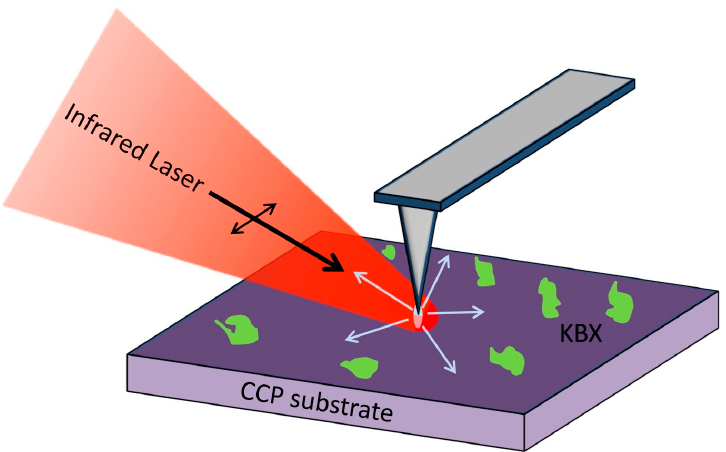
Figure 2. Schematic drawing of the s-SNIM setup. s-polarized mid-infrared light is focused onto an AFM tip/CCP-sample (purple) junction, confining the near field under the tip apex. The coupled tip/sample dipole interaction scatters back into the far-field and is demodulated at higher cantilever harmonics. Note the greenish parts at the sample surface that represent the patchy adsorption of KBX molecules to the CCP.